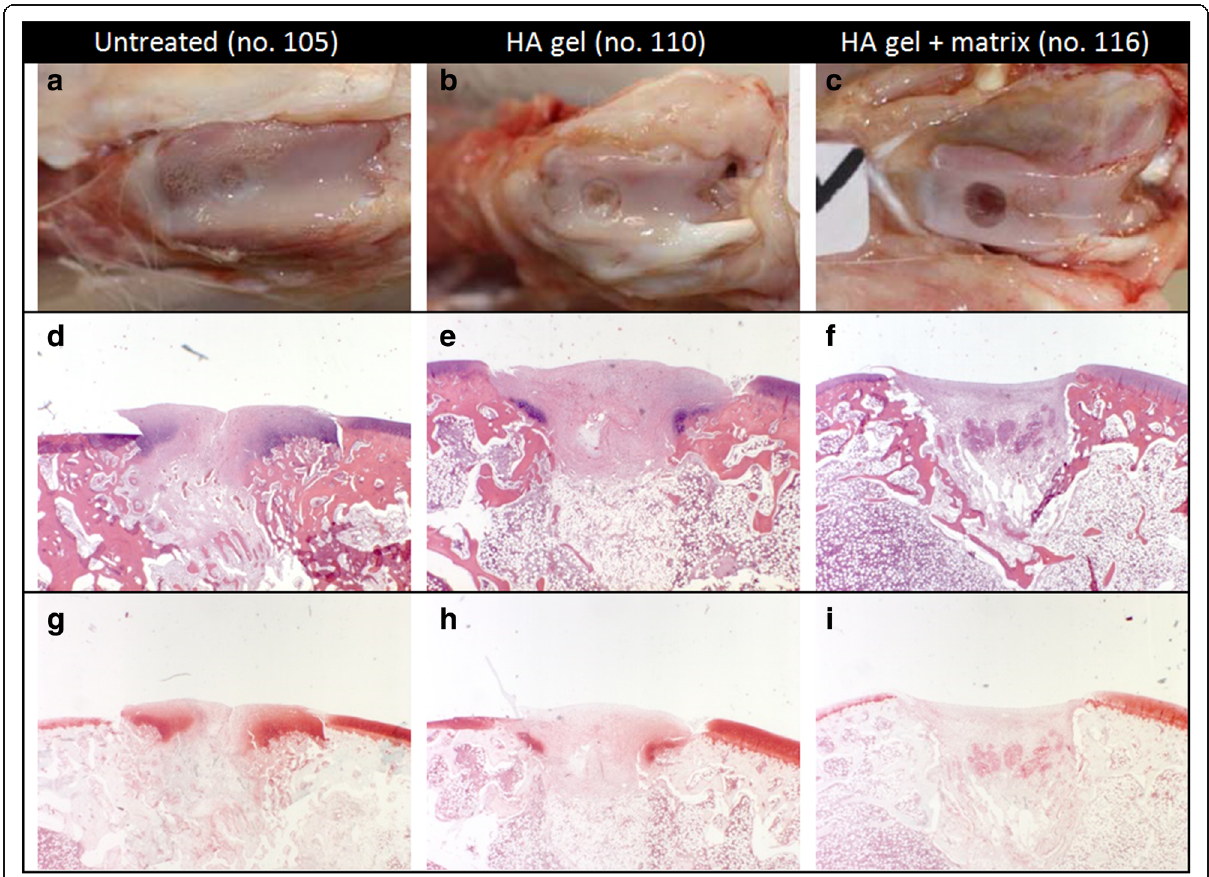
Fig. 2 Gross morphology and histology of one representative rabbit per group sacrificed 4 weeks after treatment. a – c shows the implantation site of the trochlea of the femur. d – f represents cross-section histology of the implantation site stained with hematoxylin and eosin (H & E). In the untreated group ( d ) the defect was filled up with repair tissue, while in the treated ones the HA gel ( e ) or HA gel + matrix ( f ) is shown very well. g – i shows cross-section histology of the implantation site stained with safranin-O. In the untreated group (g) the highest proteoglycan staining ( red ) was detected. The HA gel group ( h ) shows a weak proteoglycan staining, while in the HA gel + matrix group ( i ) no proteoglycan was detected on the implantation